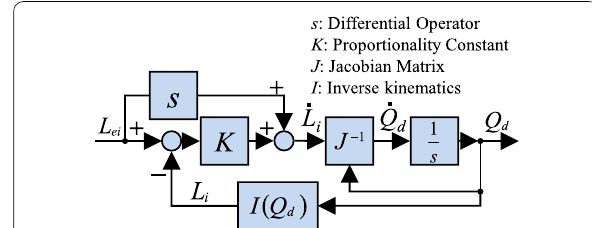
Fig. 6 Iterative calculation of the developed